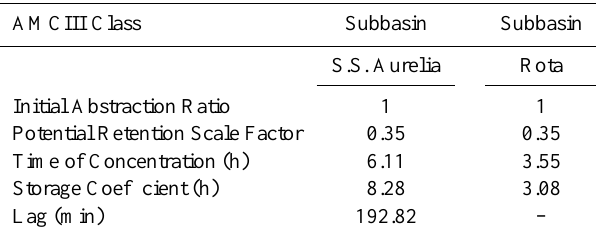
Table 3. Parameters values for models calibrated with radar data.